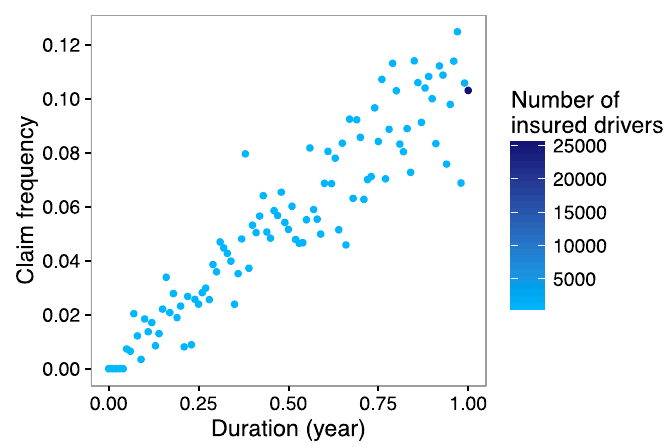
Figure 3. Distribution of the observed number of claims vs. distance traveled.